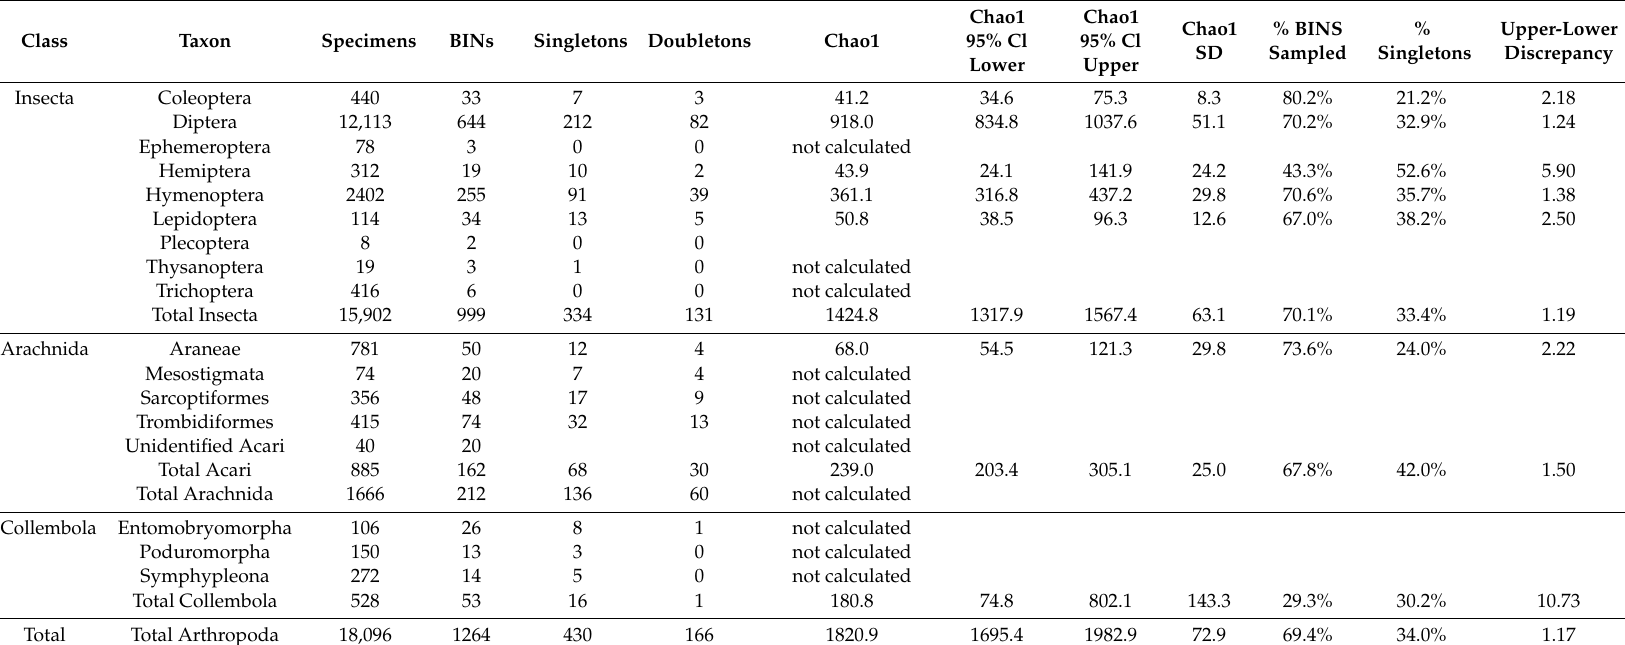
Table 2. Summary of the studied material at the class and order